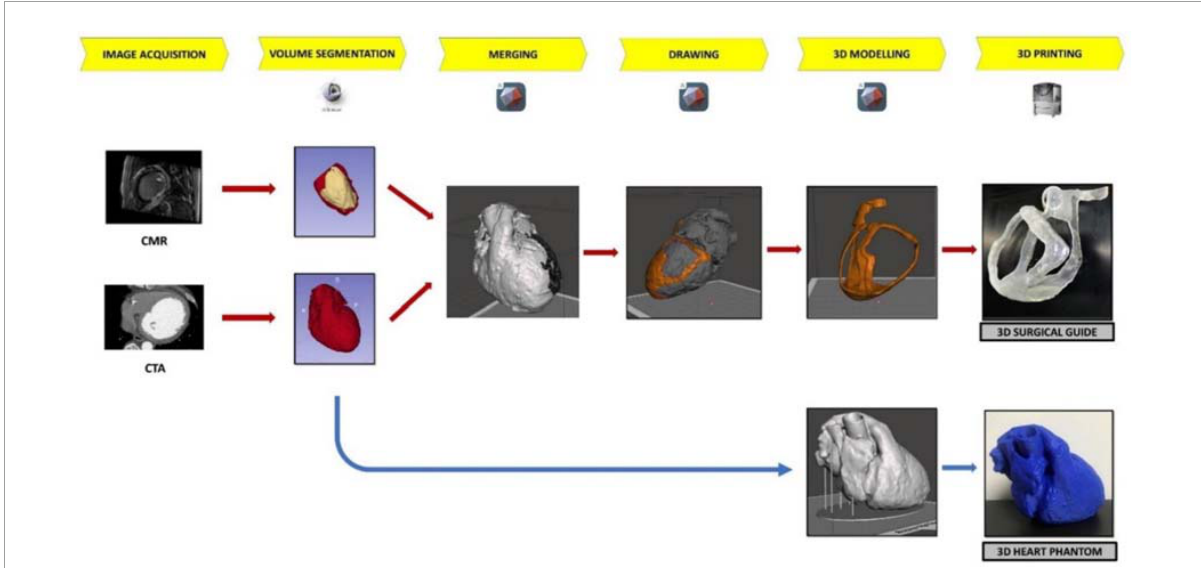
FIGURE2 The workflow of 3D surgical guide and the 3D heart phantom. The workflow describes the main steps of surgical guide and heart phantom development process from the acquisition data to 3D printing.